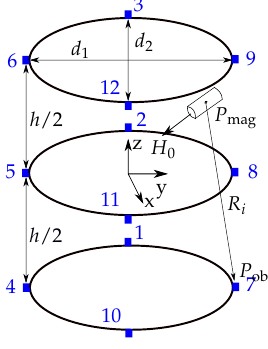
Figure 3. Localization scenario of a permanent magnet with the proposed localization system and the reference coordinate